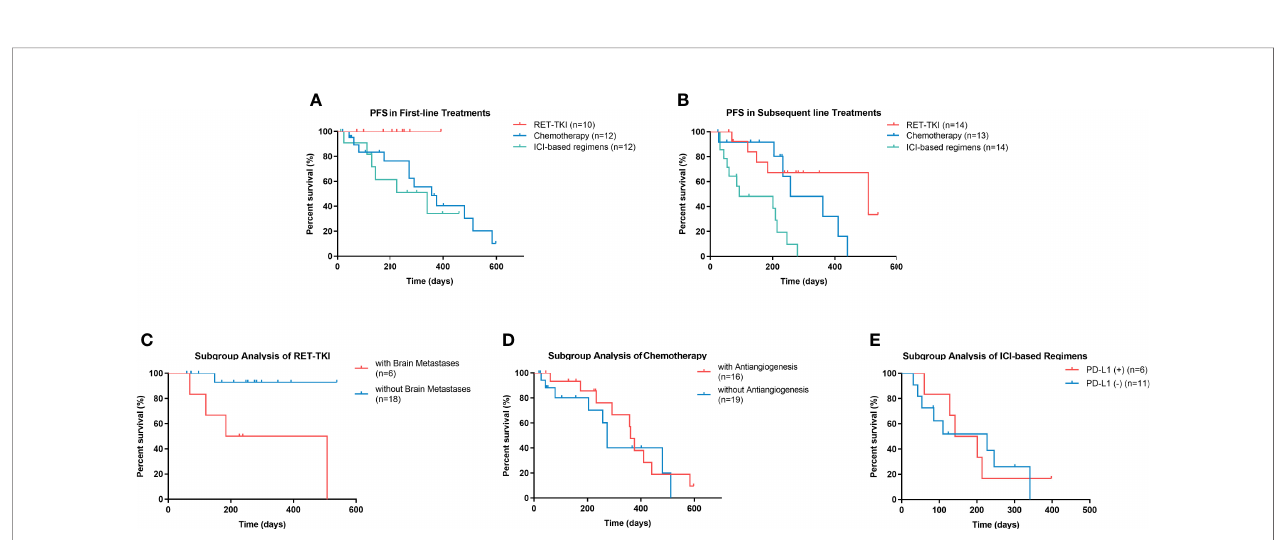
FIGURE 4 | Progression-free survival (PFS) of patients with rearranged during transfection rearrangements (RET) in different conditions. (A) PFS of patients with RET-TKI, chemotherapy, or ICI-based regimens in fi rst-line treatments. (B) PFS of patients RET-TKI, chemotherapy, or ICI-based regimens in subsequent-line treatments. (C) PFS of patients treated with RET-TKI with or without brain metastases. (D) PFS of patients treated with chemotherapy with or without angiogenesis inhibitors. (E) PFS of patients treated with ICI-based regimens with negative PD-L1 expression or positive one. PFS, progression-free survival, RET-TKI, rearranged during transfection-tyrosine kinase inhibitors. ICI, immune-checkpoint inhibitor. MKI, multi-kinase inhibitor; PD-L1, programmed death-ligand 1.